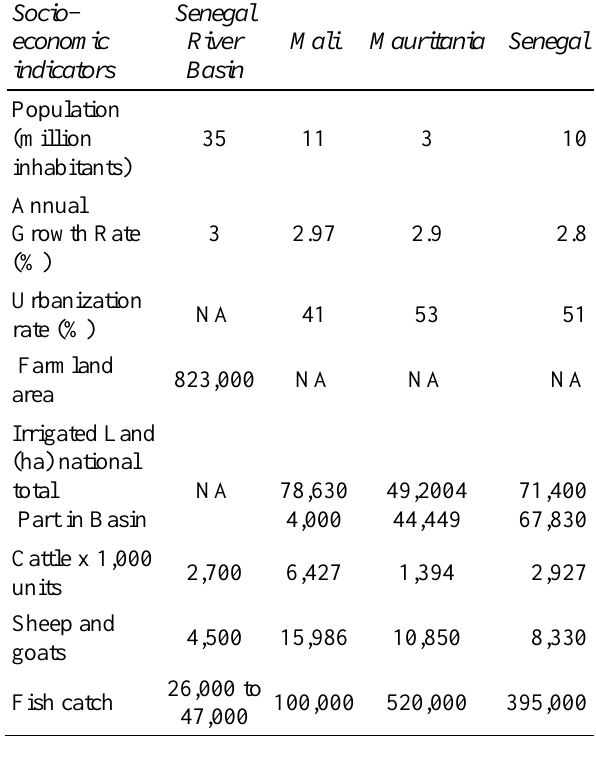
Table 3: Summary of Socio-Economic